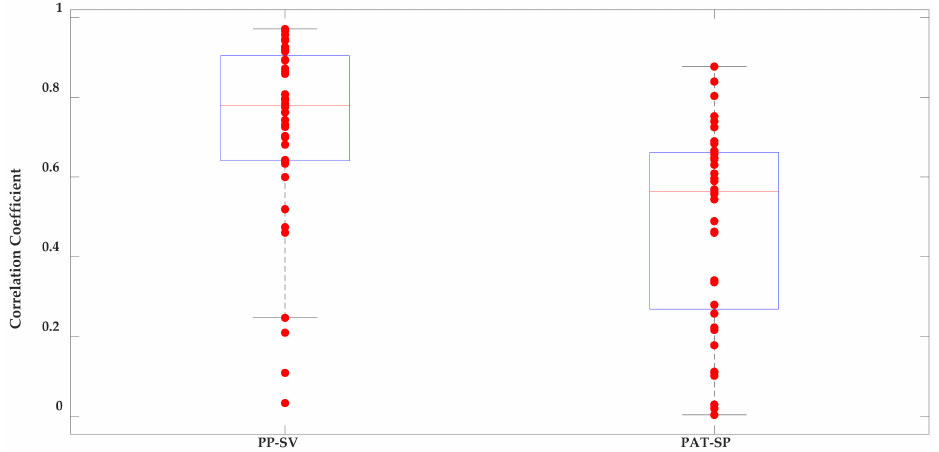
Figure 9. Boxplots of the correlation coefficients for the pulse pressure (PP)–stroke volume (SV) and pulse arrival time (PAT)–systolic pressure (SP) predictor–response